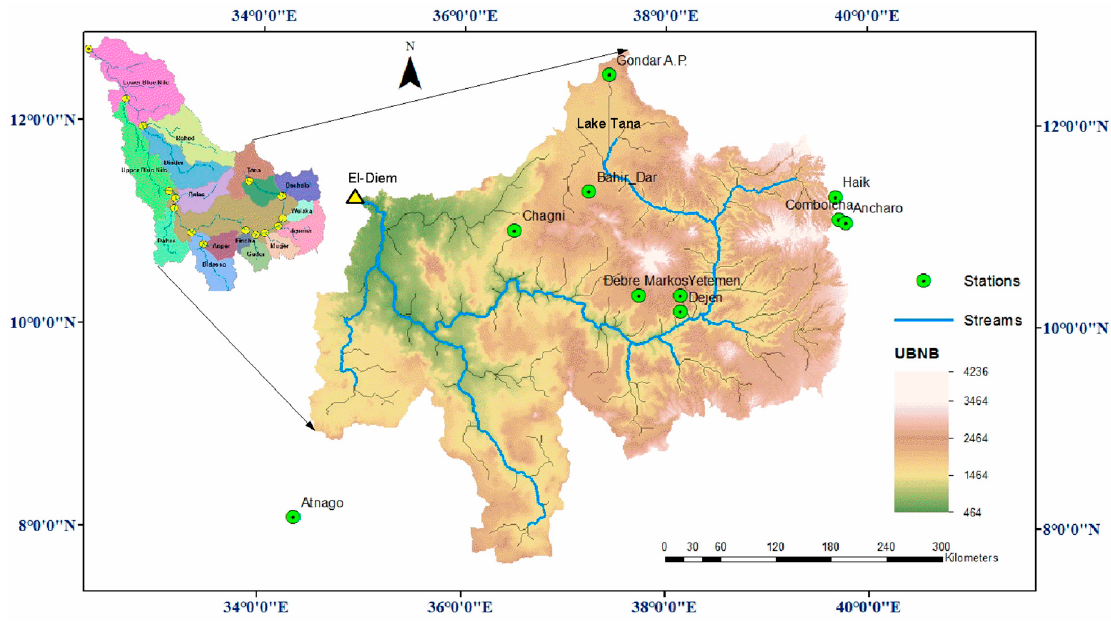
Figure 1. The geographical location of the Upper Blue Nile Basin (UBNB) and ground rainfall stations locations. The El-Diem station, which locates in the most downstream point (i.e., the outlet) of the Upper Blue Nile Basin (UBNB), is also shown.